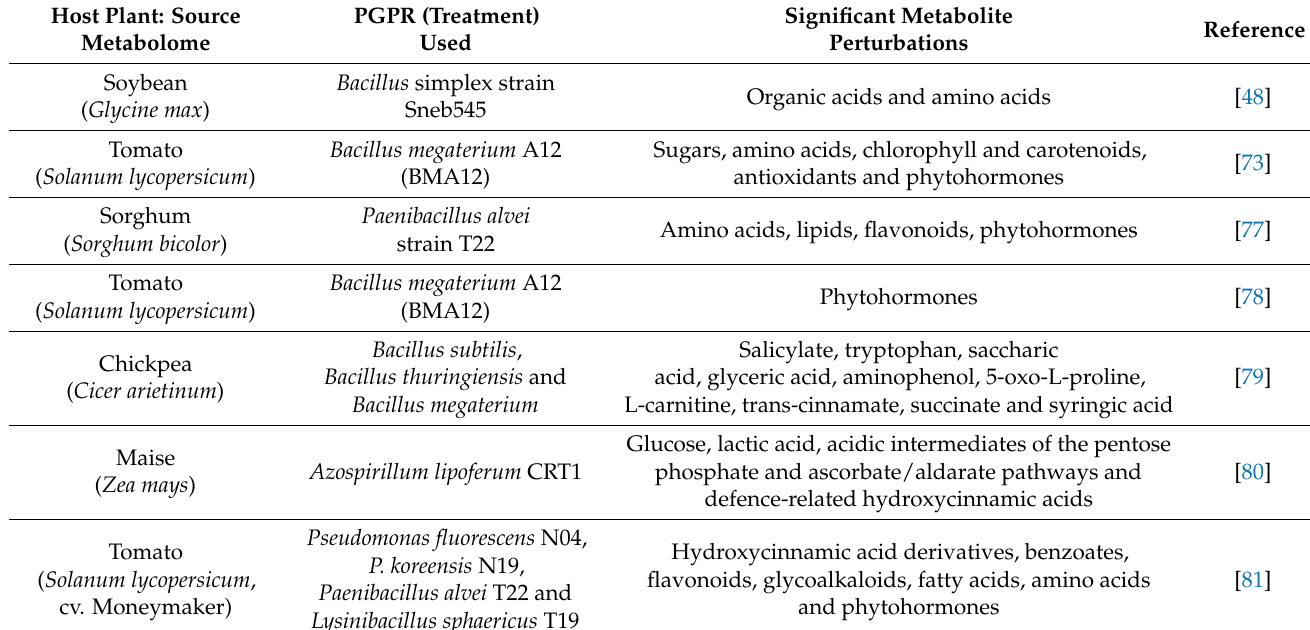
Elucidated metabolome perturbations in selected plants due to plant–microbe (PGPR)